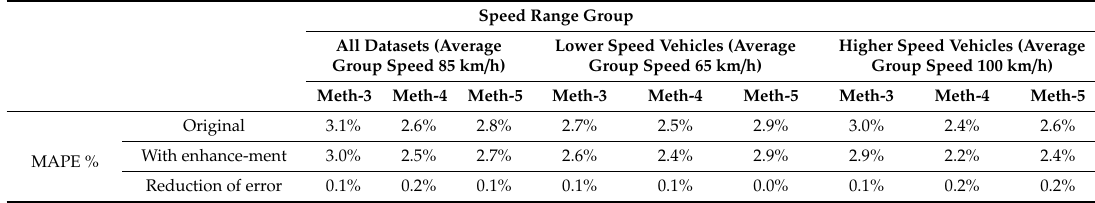
Table 3. Accuracy enhancement technique performances with three different speed estimation methods and different speed groups. MAPE, mean absolute percentage error.